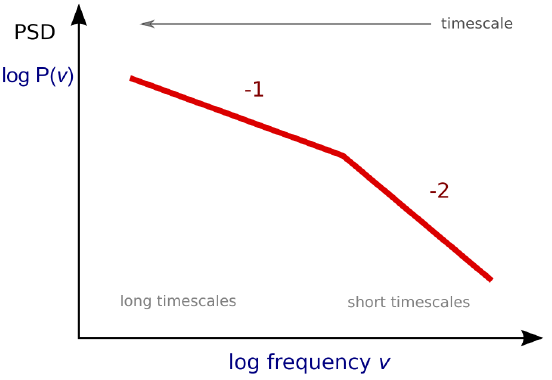
Figure 9. The PSD behavior of the VHE emission from PKS 2155-304 is suggestive of a break from flicker ( β = 1) to Brownian ( β = 2) power-law noise at a break frequency corresponding to a break time of t b ∼ 1